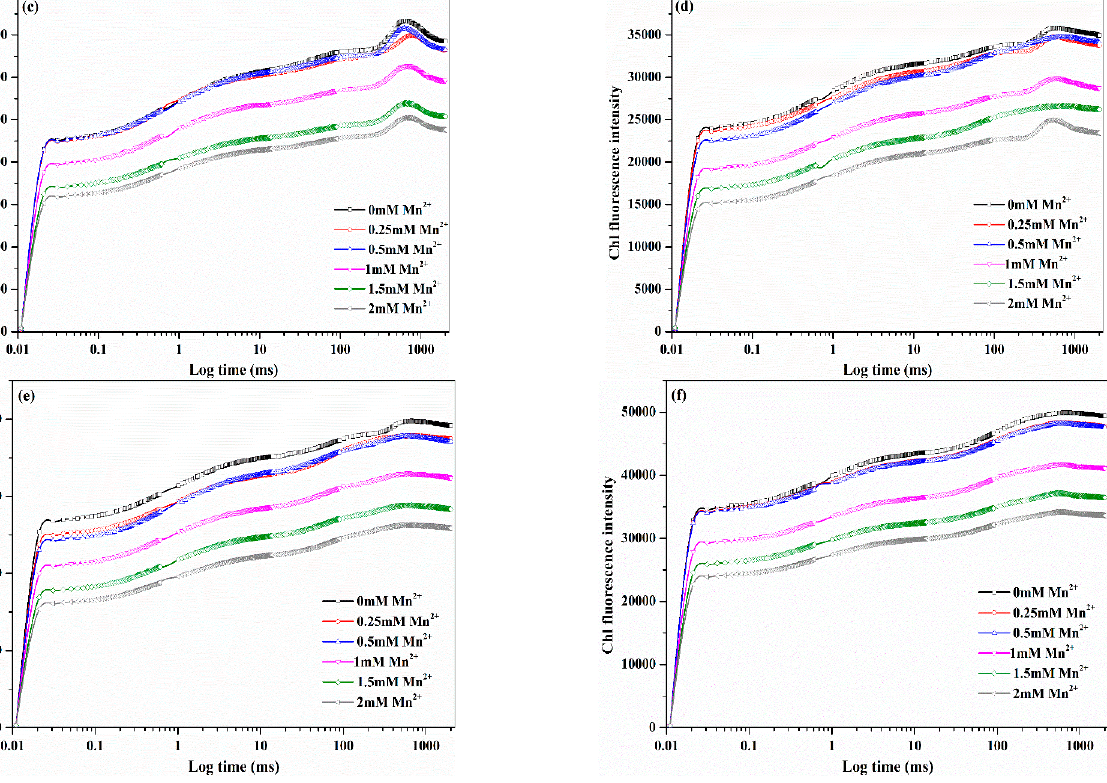
Figure 2. Log scale OJIP chlorophyll fluorescence transients of the mixed MnOMs under different Mn 2+ concentrations at the cultivation times of ( a ) 0 day, ( b ) 2 days, ( c ) 4 days, ( d ) 6 days, ( e ) 8 days, and ( f ) 10 days.